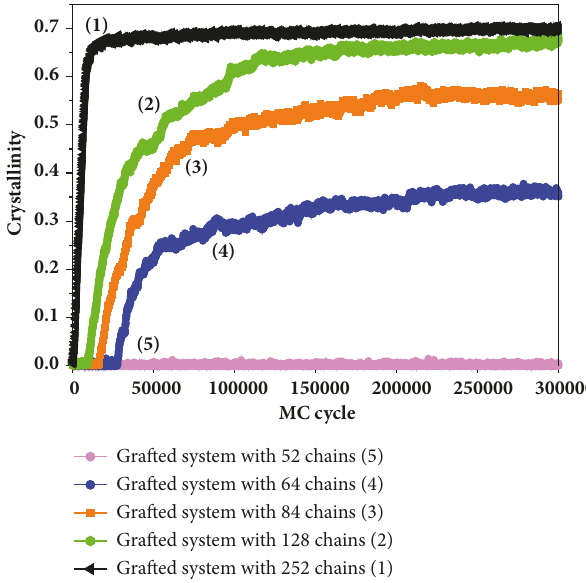
Figure 4: Evolutions of crystallinity for five systems with different grafting densities during isothermal crystallization process, respec-